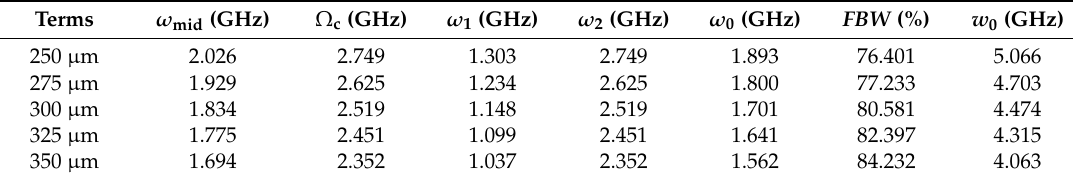
Table 4. Values and calculated results of the terms in Equations (2)–(4).